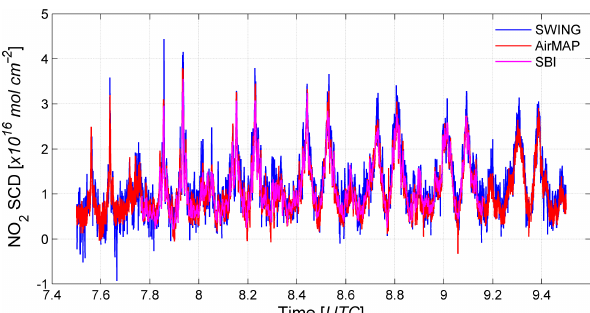
by averaging the observations of each across-track scan be- tween − 4 and + 4 ◦ viewing zenith angle (VZA). Note that differences in the effective noise levels are partly caused by differences in the instrument IFOV, integration time, and av- eraging of observations. This is further discussed in Sect.